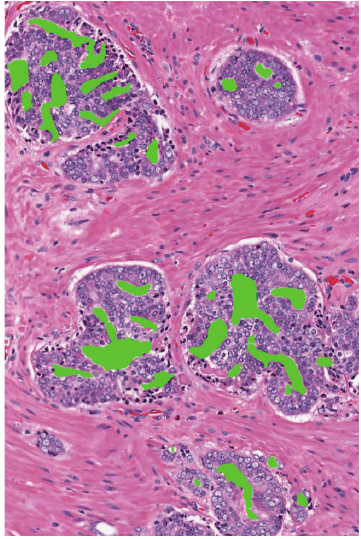
Figure 2: Image capture of true papillary grade 4 pattern, 1500 × 1000 pixels, after pseudolumen annotation. Note bridging across gland space. Patient had PSA failure (100x).